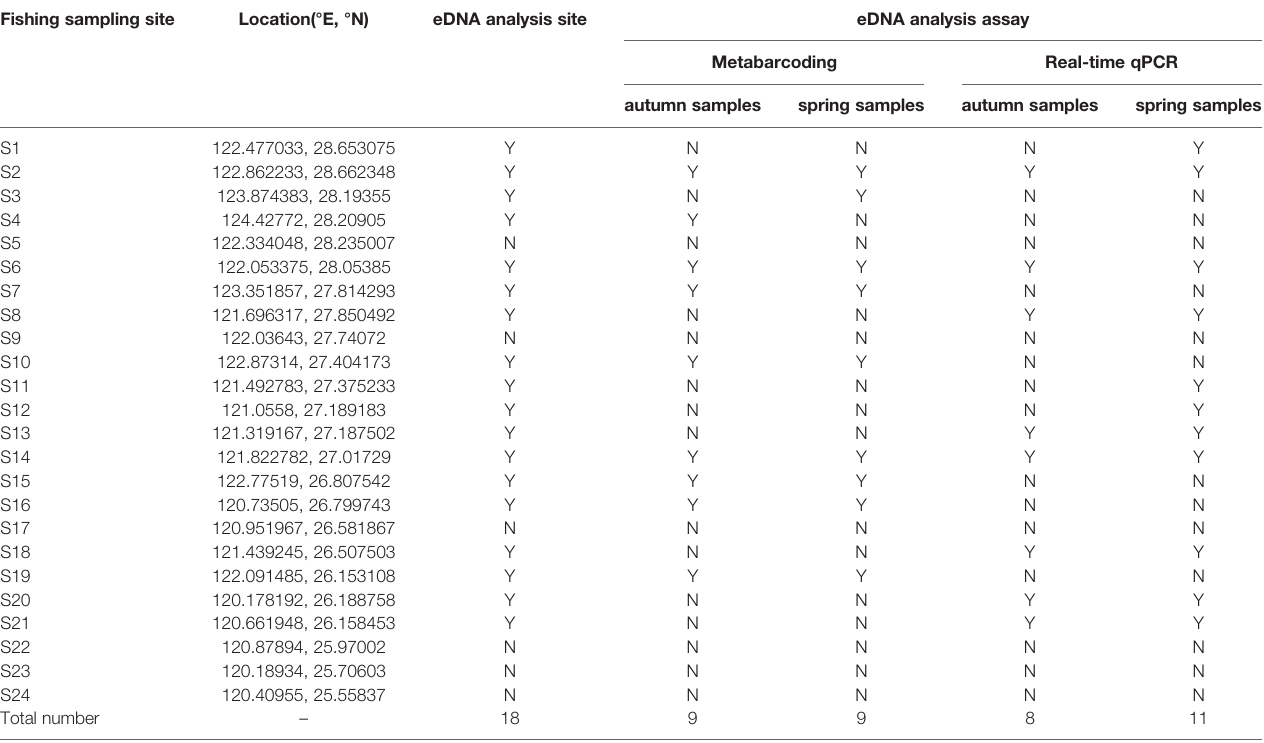
TABLE 1 | Sampling sites of Larimichthys crocea in the East China Sea. Fishing sampling site Location(°E,